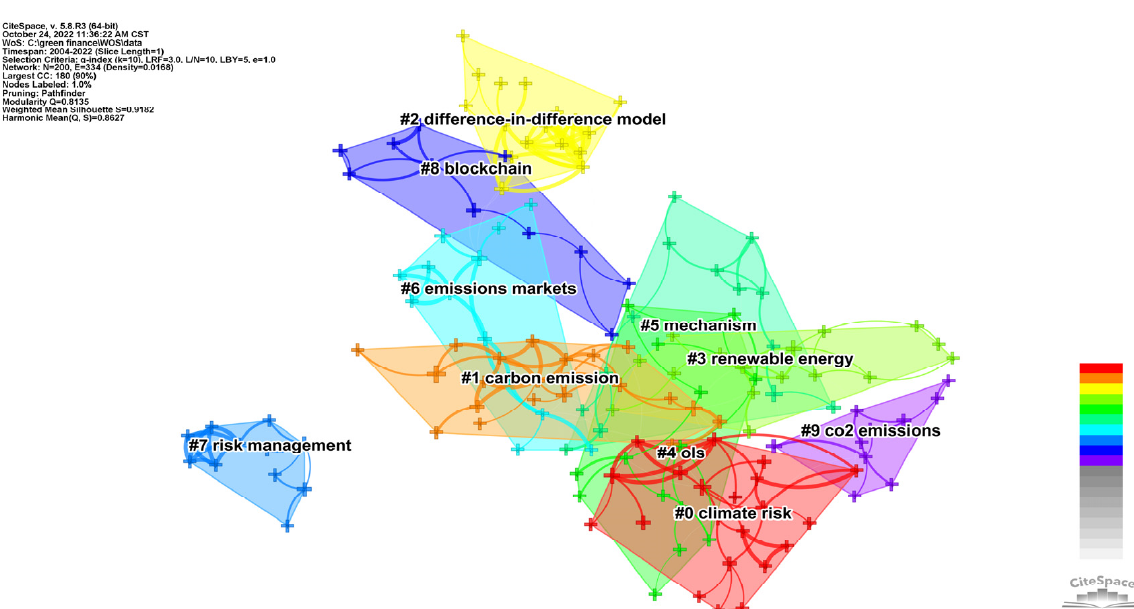
Figure 11. WOS keyword clustering.